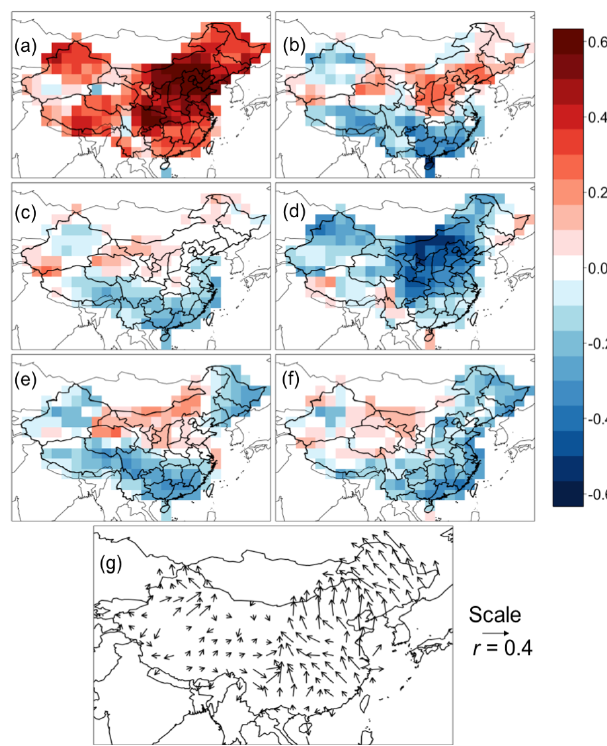
Figure 2. Correlation coefficients of daily PM 2 . 5 with different me- teorological variables in Table 1, including (a) surface air temper- ature ( X 1 , K), (b) relative humidity ( X 2 , %), (c) precipitation ( X 3 , mmd − 1 ) , (d) sea level pressure ( X 4 , hPa), (e) pressure tendency ( X 5 , hPad − 1 ) , (f) wind speed ( X 6 ,ms − 1 ) , and (g) wind direction ( X 7 and X 8 , unitless), for China from June 2014 to May 2017. PM 2 . 5 data are from MEP. Meteorological data are deseasonal- ized by subtracting 31-day moving averages and normalized, and daily total PM 2 . 5 are also deseasonalized the same way to focus on day-to-day variability. Only values with significant correlations at p value ≤ 0.05 are shown. Panel (g) is plotted by finding the vec- tor sums of the correlation coefficients for X 7 and X 8 , with posi- tive correlations pointing eastward and northward, respectively. The direction of the vector sum indicates the prevalent wind direction when PM 2 . 5 has a positive